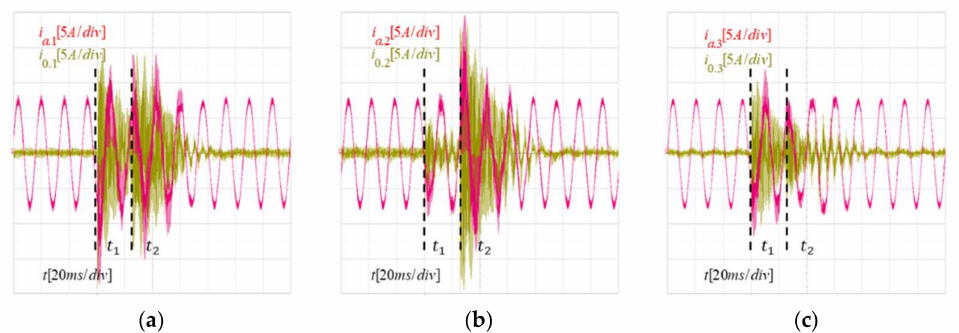
Figure 16. Results of experiment of control of phase errors occurred during control ( a ) phase a output current and zero − sequence current of inverter 1, ( b ) phase a output current and zero − sequence current of inverter 2, ( c ) phase a output current and zero − sequence current of inverter 3.